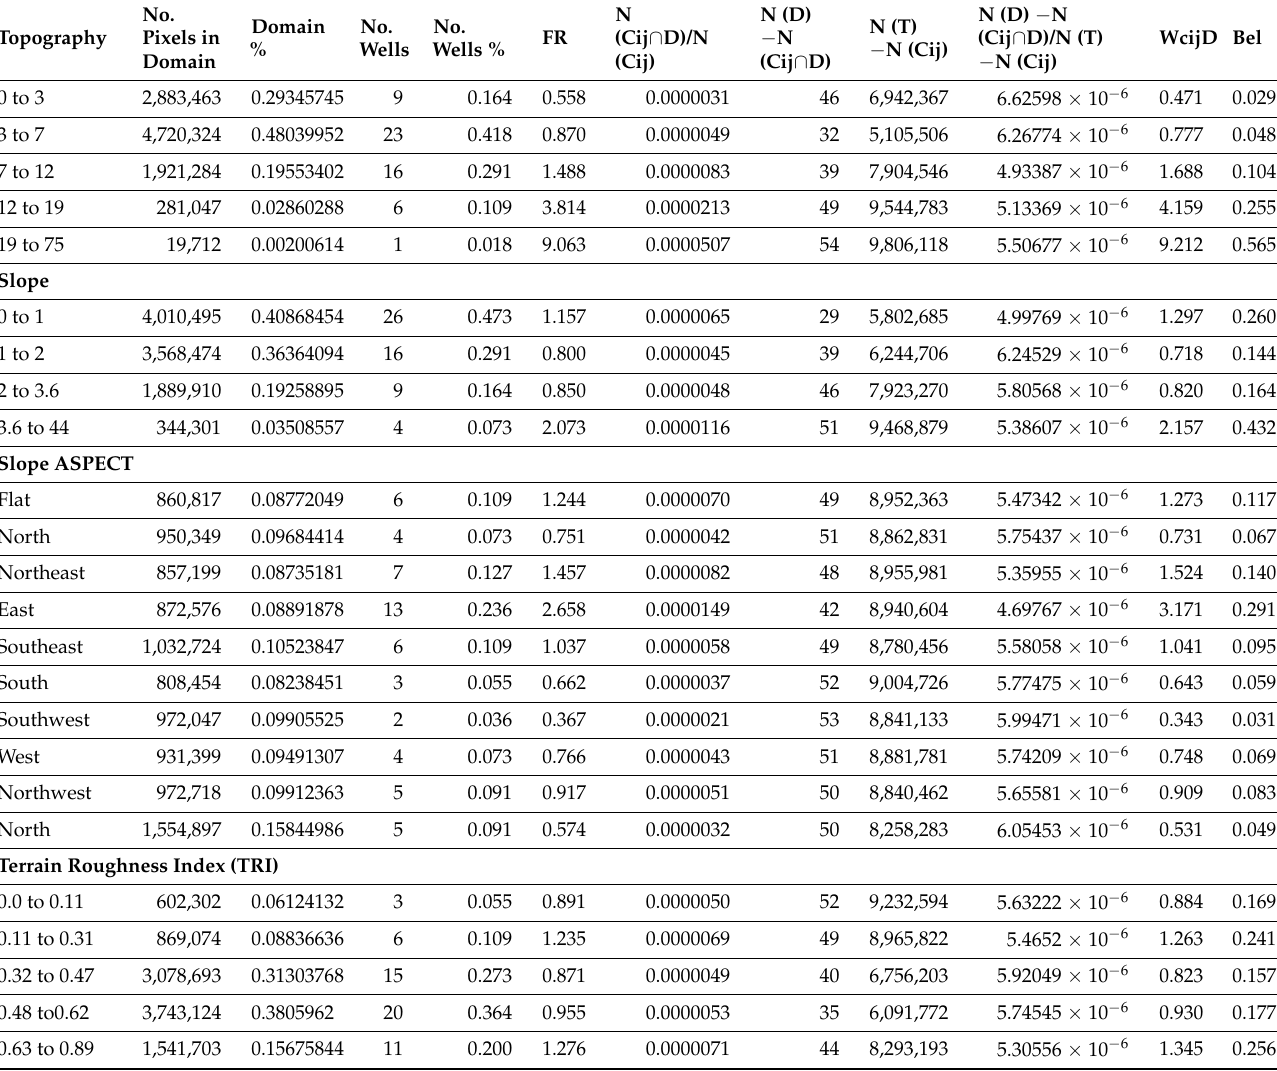
Table 2. Groundwater factors of the adopted models in the study